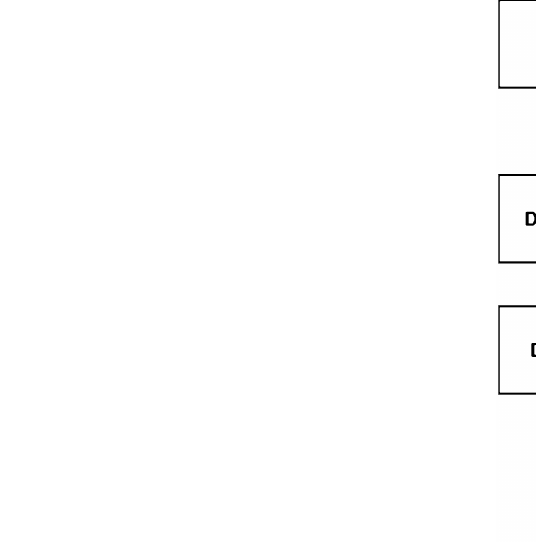
Figure 3 The scheme of a GRU neural network. Each block represents a layer and contains layer’s name, the name of a parameter representing the input, and output size of a layer. Arrows indicate the direction of the forward propagation of data through the